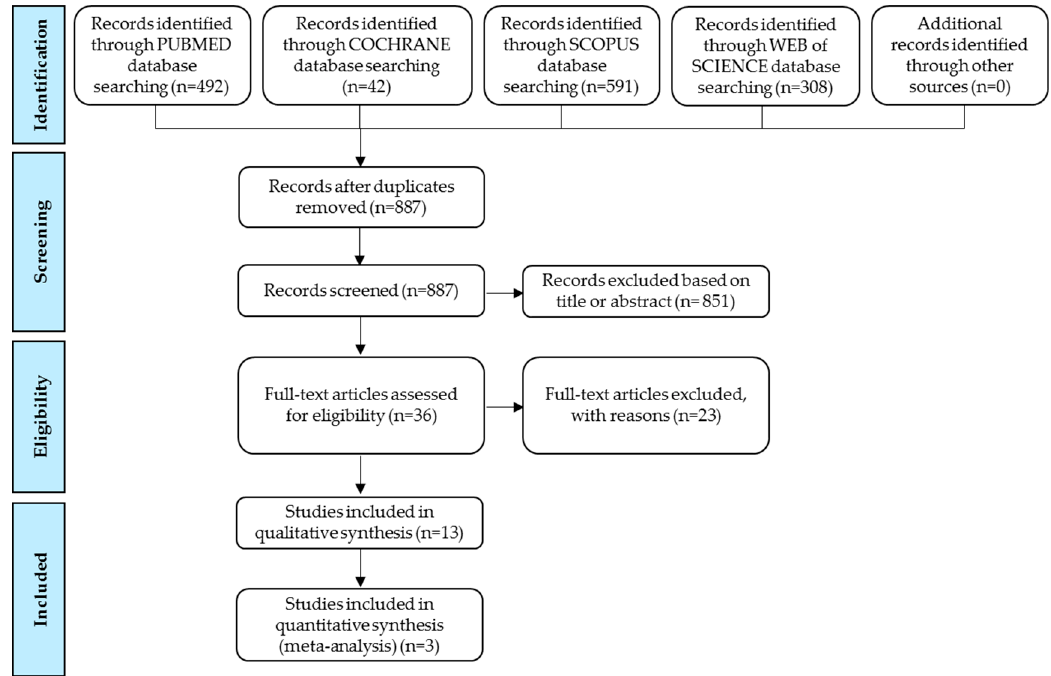
Figure 1. Study selection process according to Preferred Reporting Items for Systematic Reviews and Meta-Analysis (PRISMA) flow chart.